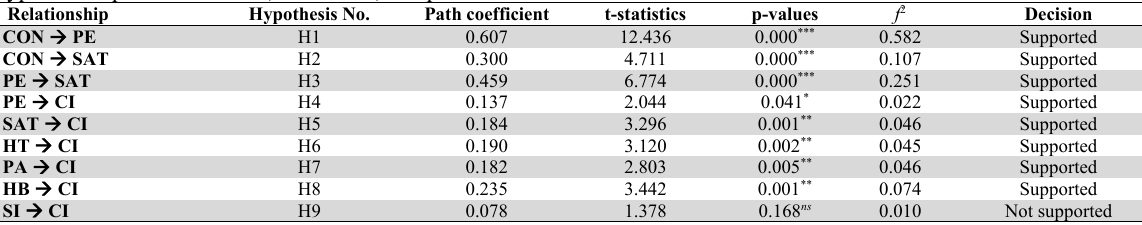
Hypotheses’ path coefficients, t-statistics, and p-values